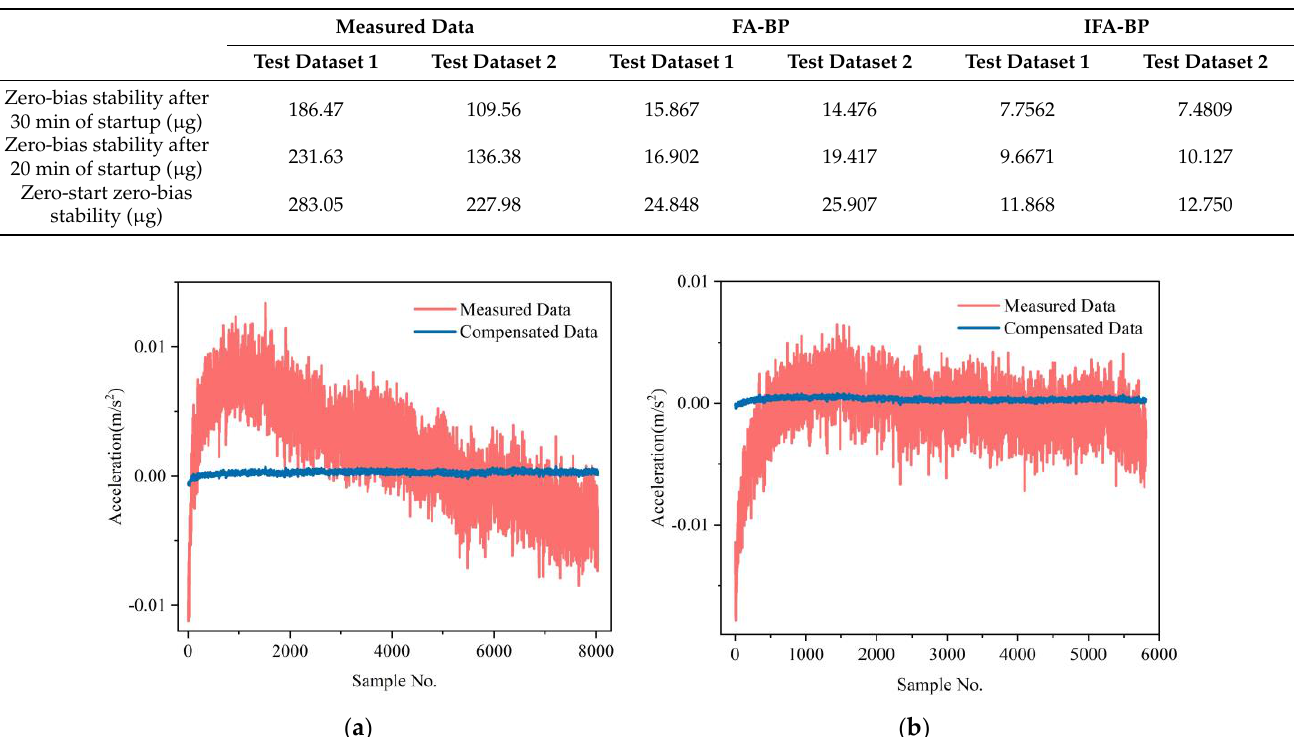
Table 1. Zero-bias stability at room temperature before and after compensation.